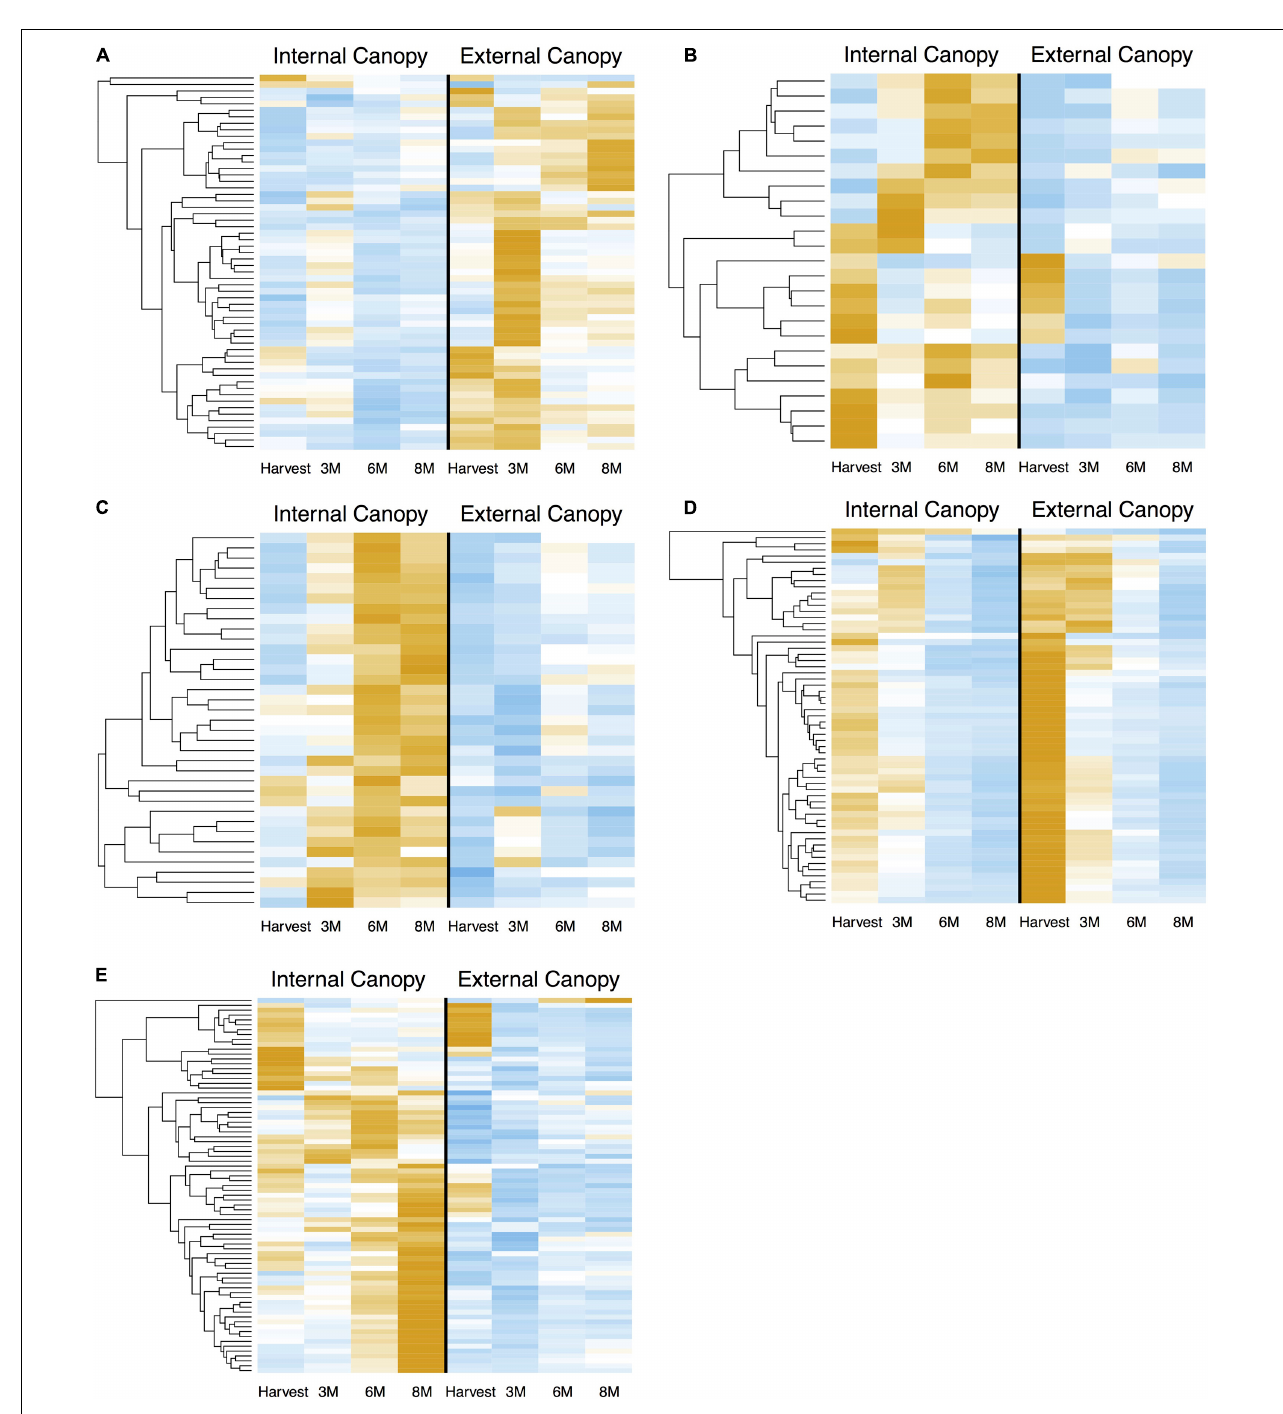
FIGURE 7 | Successive shifts of gene expression that are associated with differential postharvest outcomes are apparent in csGNC modules from I AD class C. DEGs in (A) cortex module 4, (B) cortex module 5, (C) cortex module 6, (D) peel module 19, (E) peel module 10, 17, 18, and 21. Orange colors indicate higher relative expression, blue indicates lower relative expression. Plots show Z-score transformation of normalized (RPKM) counts and are independently scaled. All features are significantly differential (Bonferroni P < 0.05) at one or more timepoints between equivalent canopy positions and are part of the indicated co-expression module. Postharvest outcomes in our experiment indicate fruit within I AD class C from external canopy positions are more mature. csGCN modules therefore contain DEGs that are associated with these different postharvest fruit quality characteristics. In addition to offering clues about the genetic control of ripening, it also suggests the possibility to use gene-expression based biosignatures to predict future fruit quality, including the capacity to ripen. DEGs are listed in Supplementary File 3 .